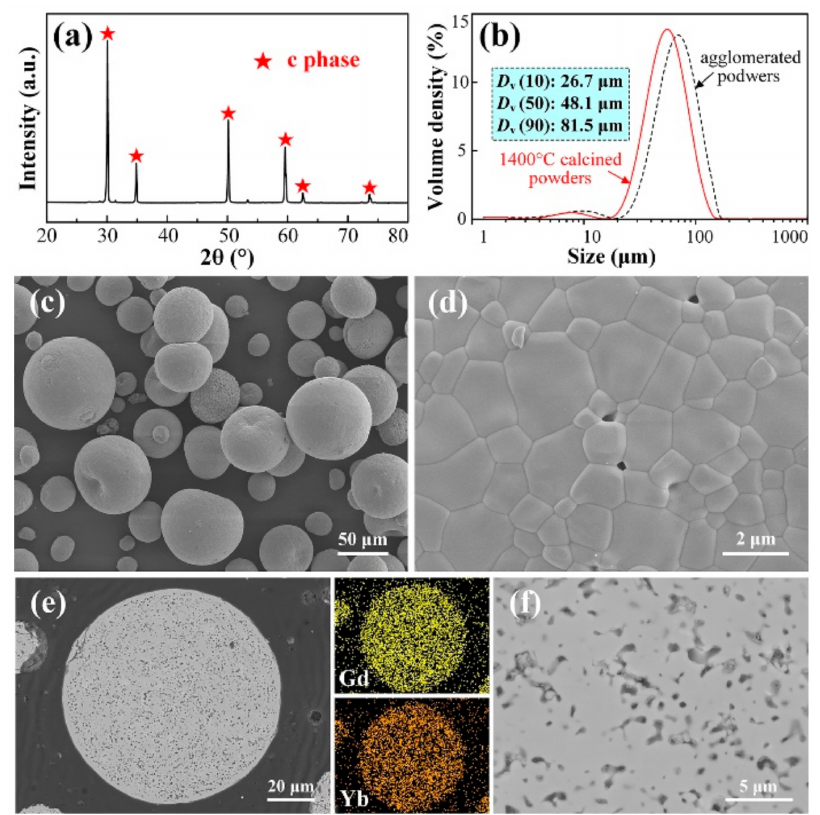
Figure 7. XRD pattern ( a ), particle size distribution ( b ), surface morphologies ( c , d ), cross-sectional microstructure ( e , f ) and corresponding EDS Gd and Yb mapping results of 10YGYZ agglomerated powders calcined at 1400 ◦ C for 3 h. ( d ) Shows the enlarged surface image of a single powder, while ( f ) is the enlarged image of certain region of ( e